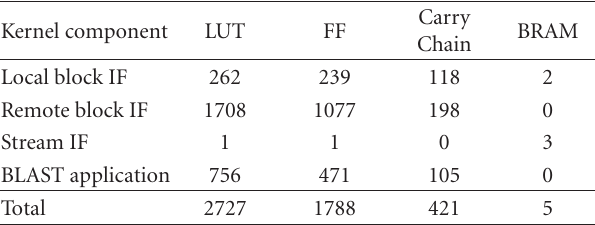
Figure 10: Block switch and stream switch network resource uti- lization in terms of lookup tables (LUTs) and flip-flops (FFs). Table 6: Resource utilization of a single BLAST Kernel on a Virtex 5 FPGA.